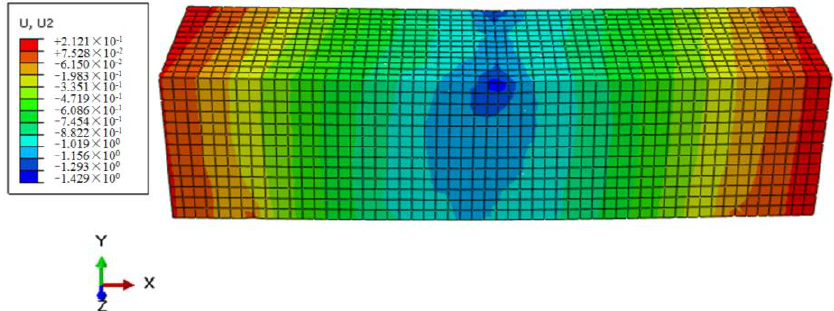
Figure 10. Displacement contours of the 3D model at 0.3% BF content at 3600 s.